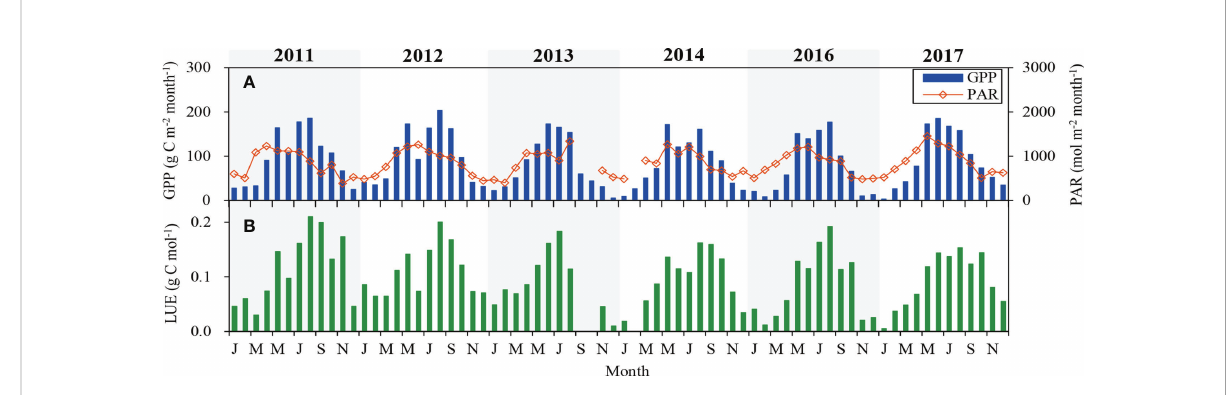
Figure 5 illustrates the response of GPP to PAR under clear and cloudy sky conditions during the growing season.